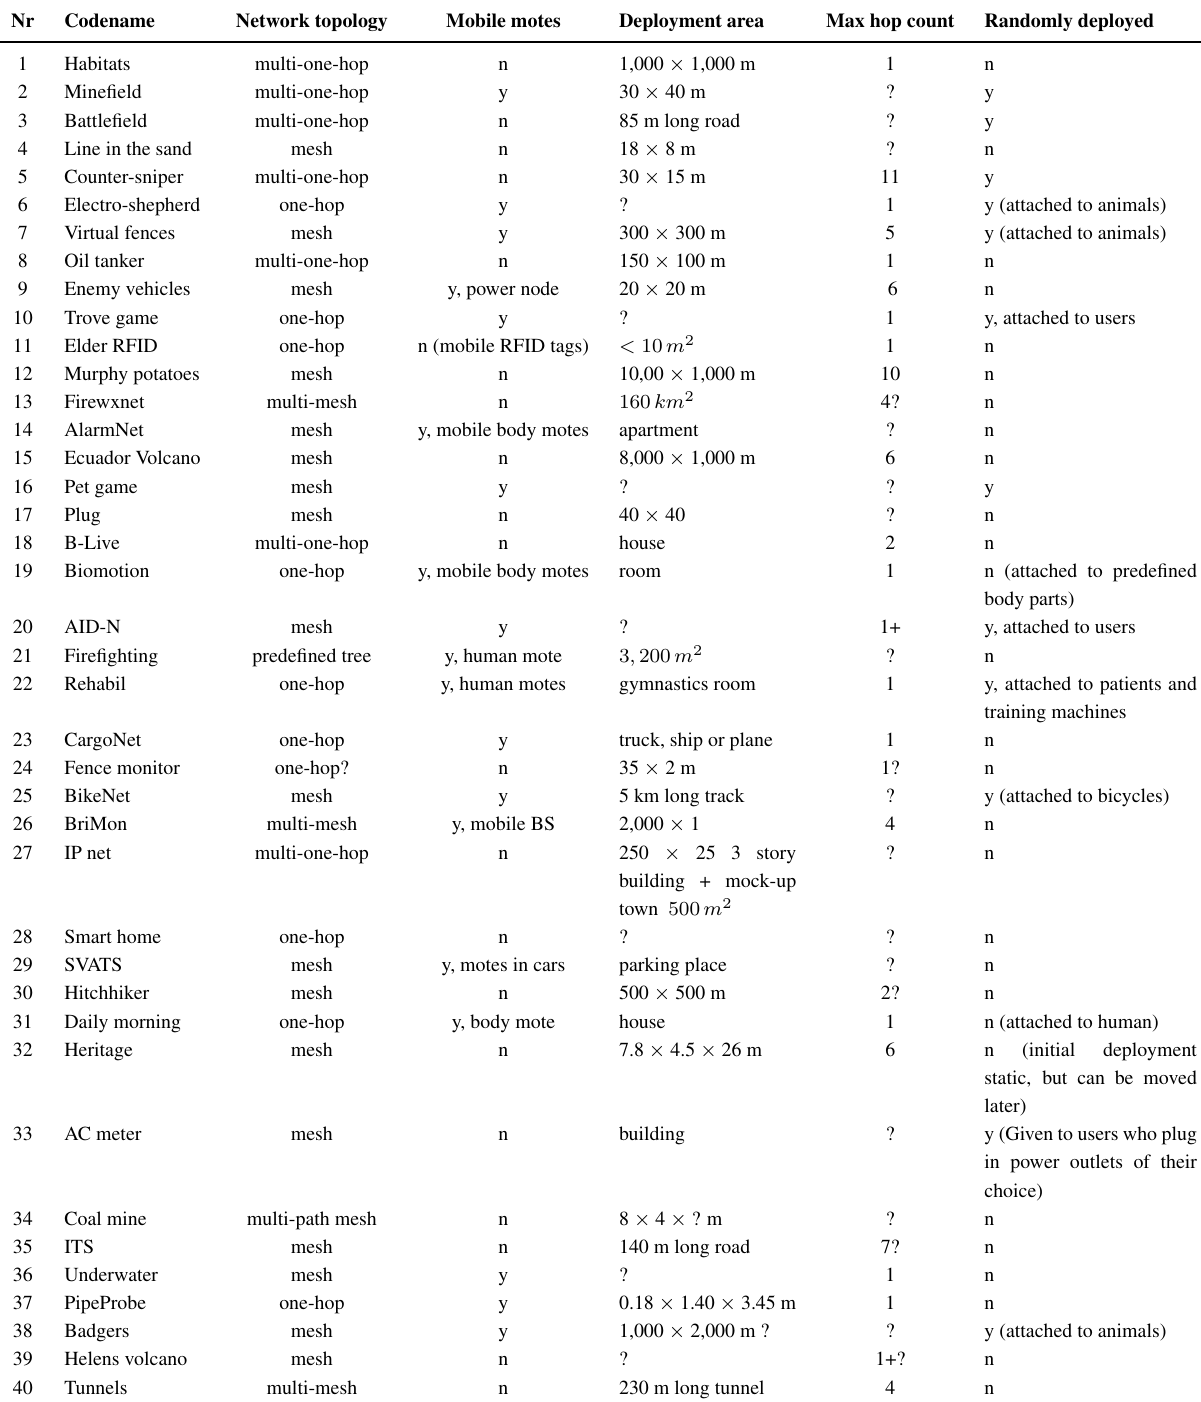
Table 10. Deployments: